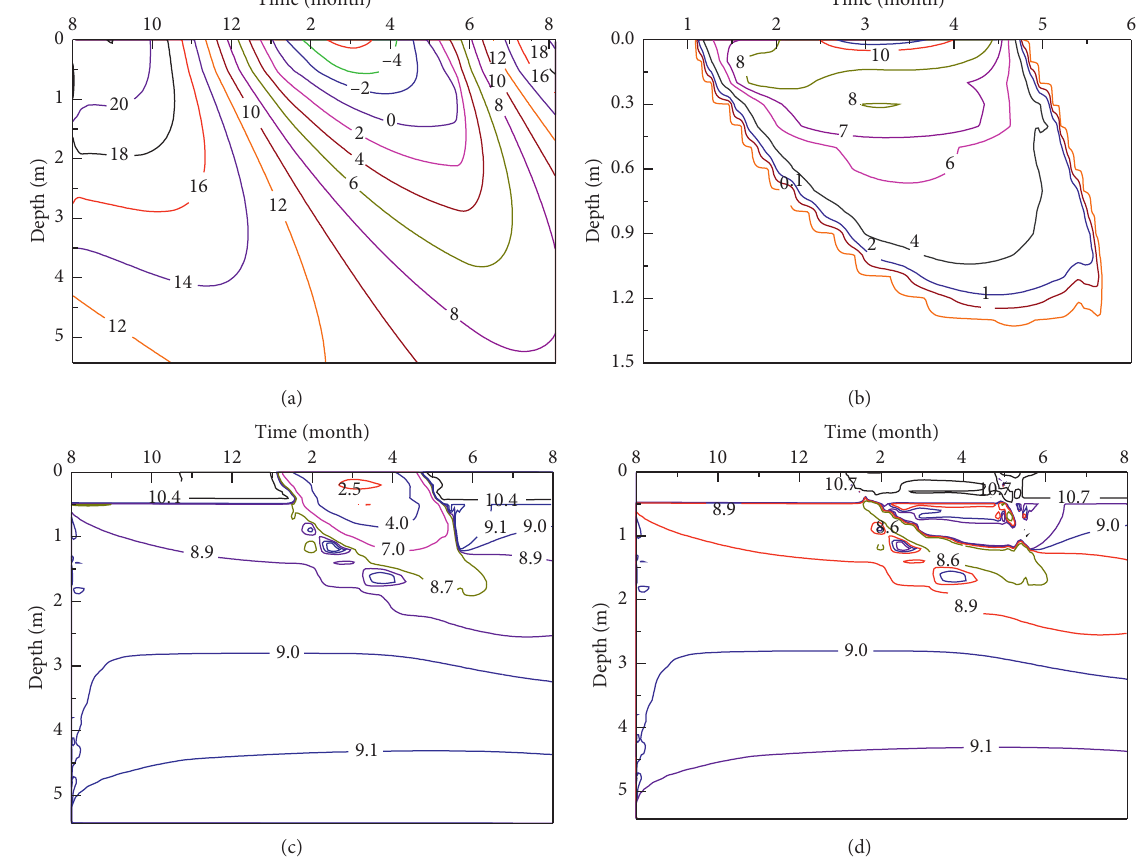
Figure 7: Trends of temperature field and moisture field of the central line. (a) Temperature ( ° C). (b) Mass content of ice (%). (c) Mass content of unfrozen water (%). (d) Mass content of moisture